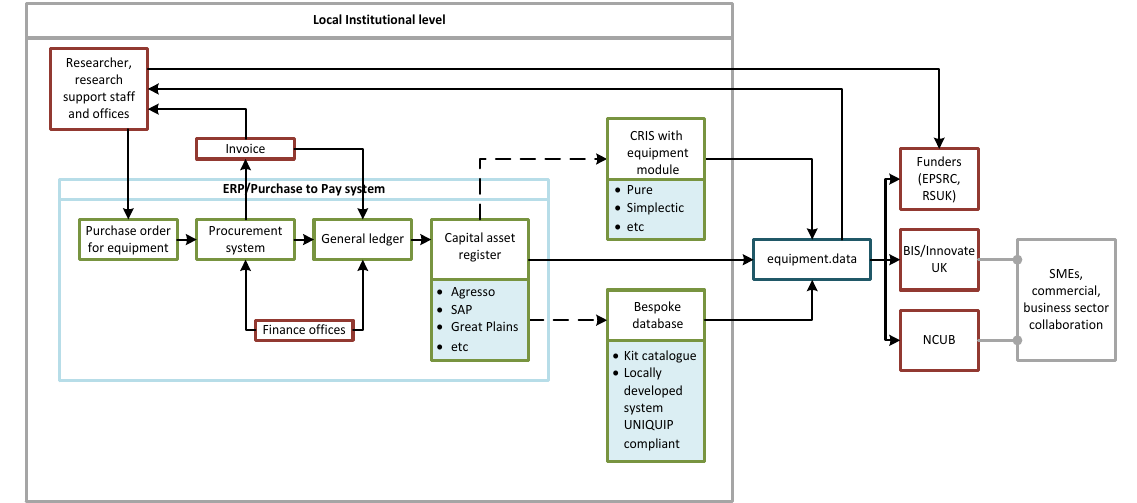
Figure 5. Equipment data workflow—Publishing equipment data in HE.